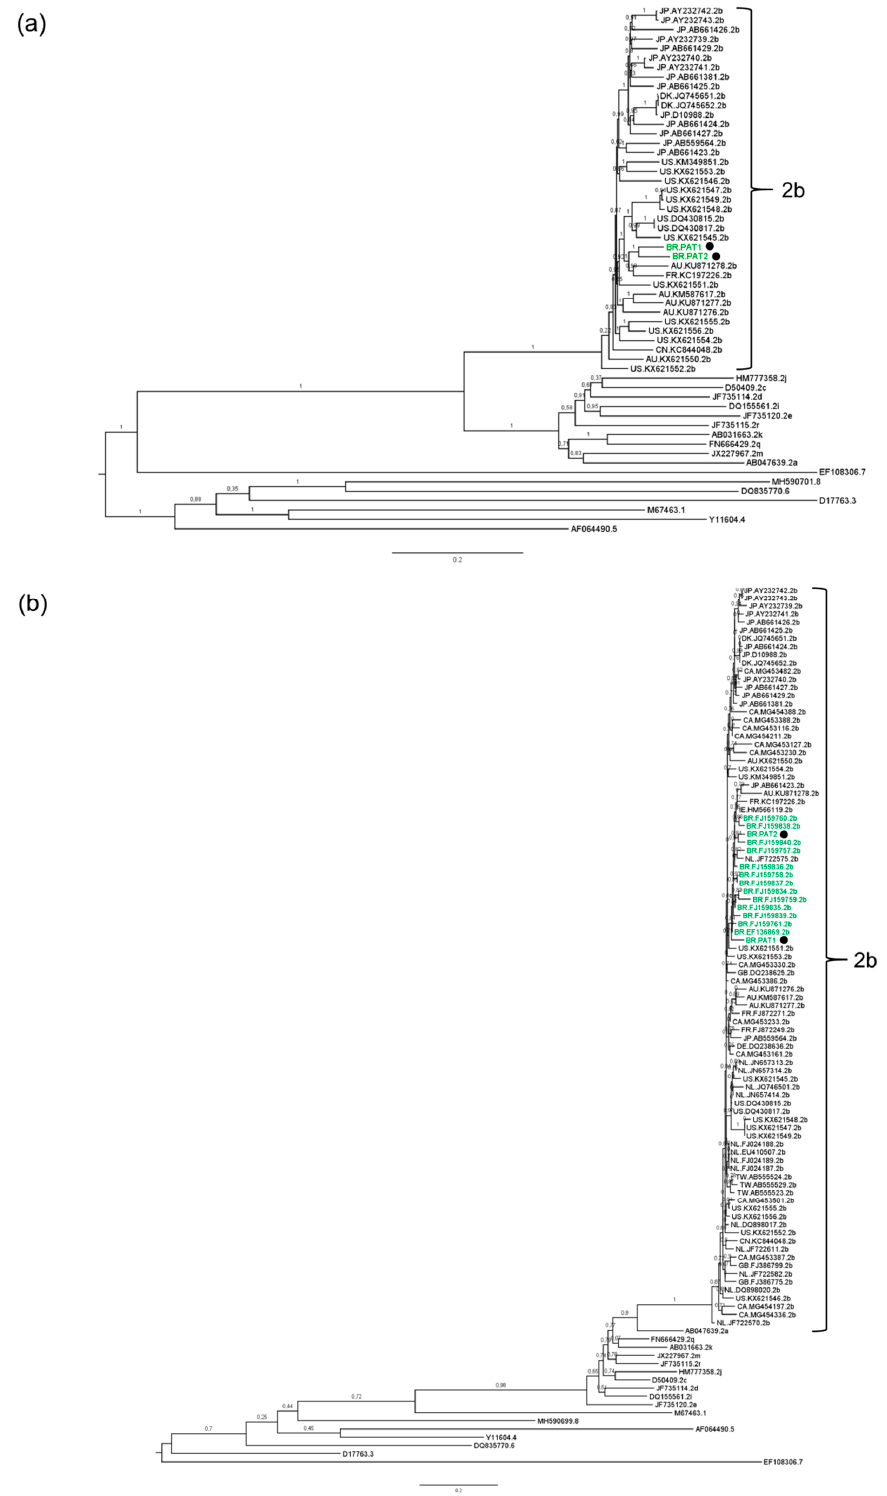
Figure 3. Phylogenetic analysis of HCV sequences. Brazilian HCV sequences are depicted in green. The sequences generated in this study are highlighted with the symbol ● . Reference sequences are indicated by the accession number followed by subtype. The numbers in branches indicate statistical support (aLRT value). ( a ) Maximum Likelihood (ML) phylogenetic tree of HCV complete genome sequences. ( b ) ML phylogenetic tree of HCV NS5B